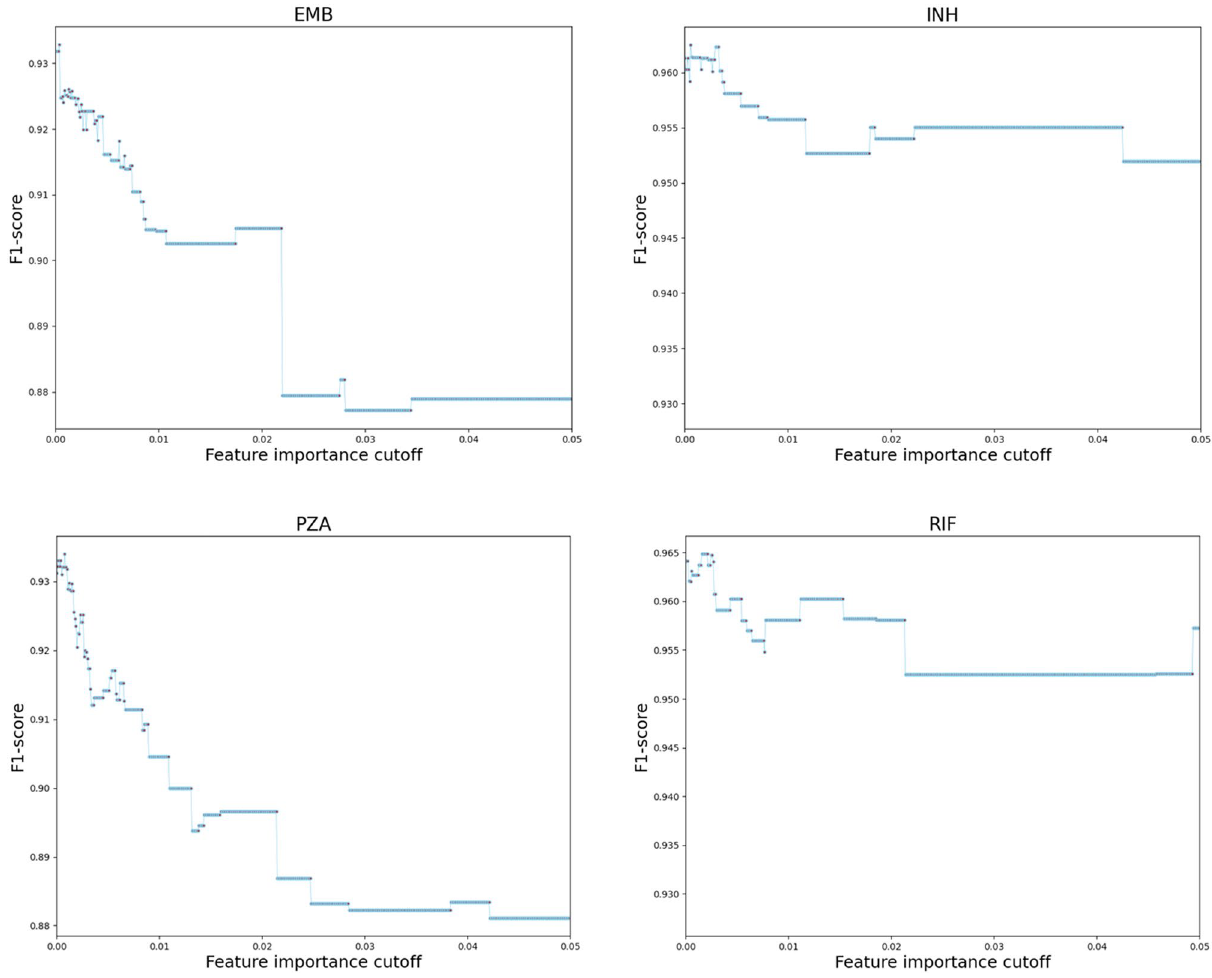
Figure 2. Feature importance cutoff tuning. For the four first-line drugs, when the cutoff increases, the F1-score quickly increases to its maximum and then continues to decrease. The cutoffs maximized F1-scores are 0.0004 (EMB), 0.0006 (INH), 0.0008 (PZA) and 0.0016